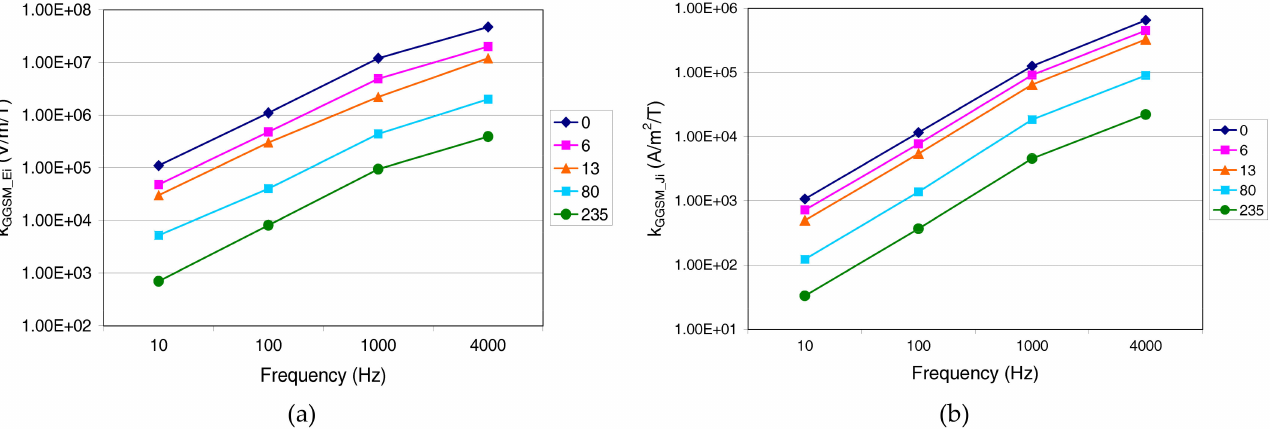
Figure 4. GGSM values for ( a ) E i (expressed as V/m/T) and ( b ) J i (expressed as A/m 2 /T), as a function of frequency and normalized B-field gradient g (=0, 6, 13, 80, 235)